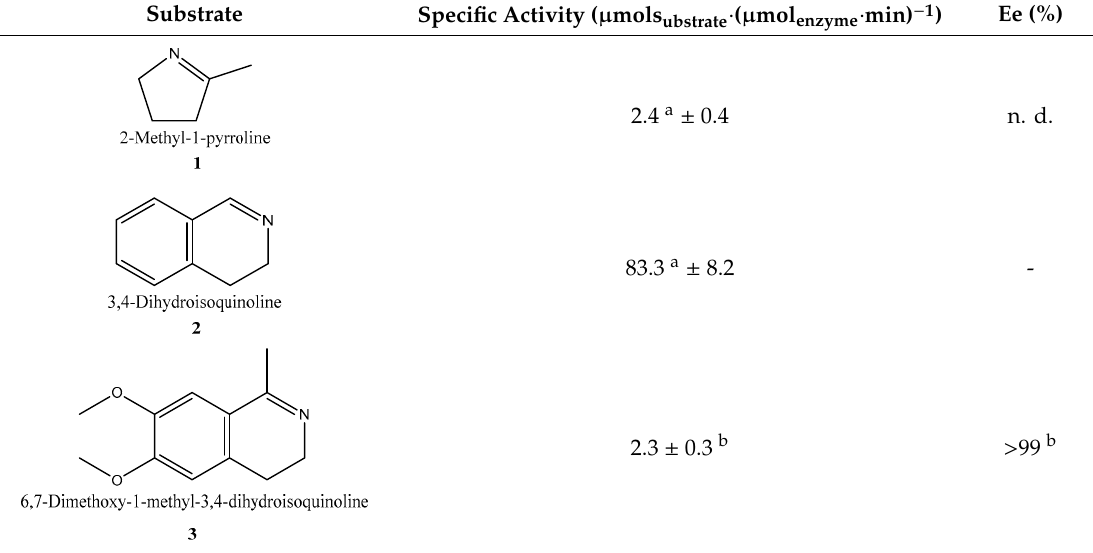
Figure 1. Kinetic analysis of the ST/SC-mediated conjugation of equimolar amounts (35 pmol) of GF3546-ST with ( a ) GDH-SC or ( b ) GDH, respectively. (Coomassie stained 12% SDS-PAGE gels, M: Color Pre-stained Protein Standard).